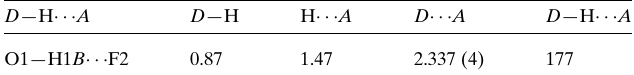
Table 2 Hydrogen-bond geometry (A˚ , (cid:4) ) for (I).